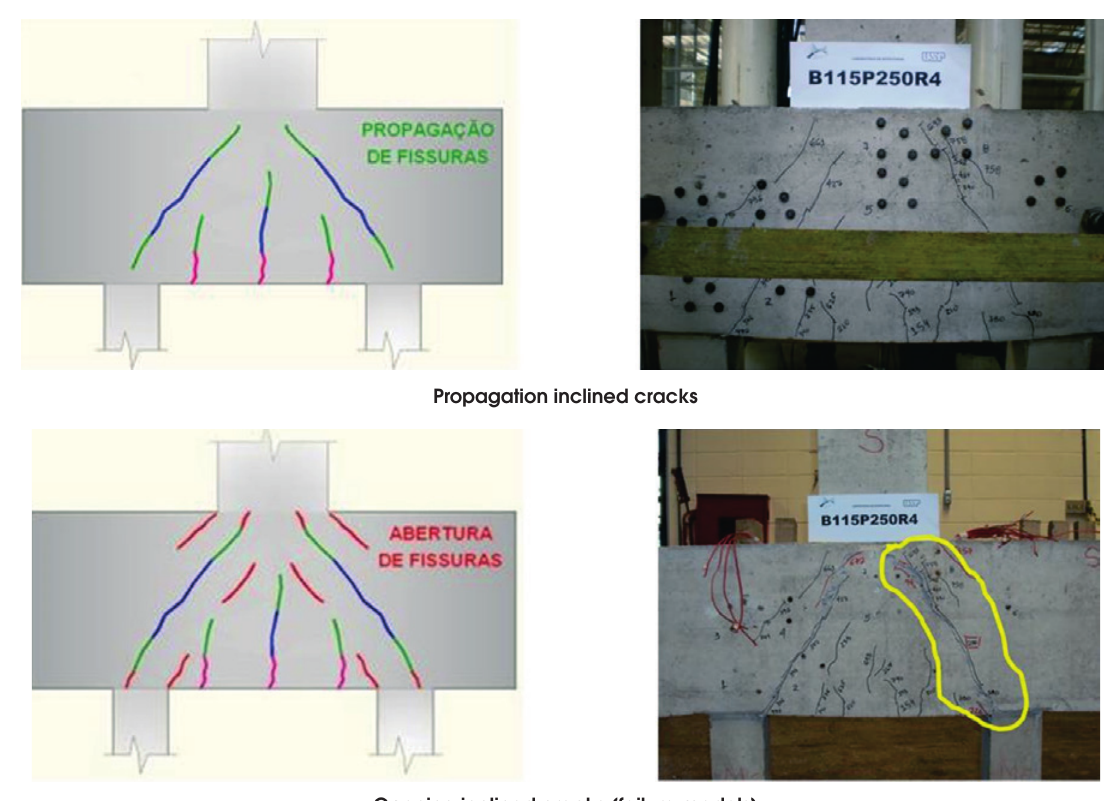
Configuration of cracking in the tested models